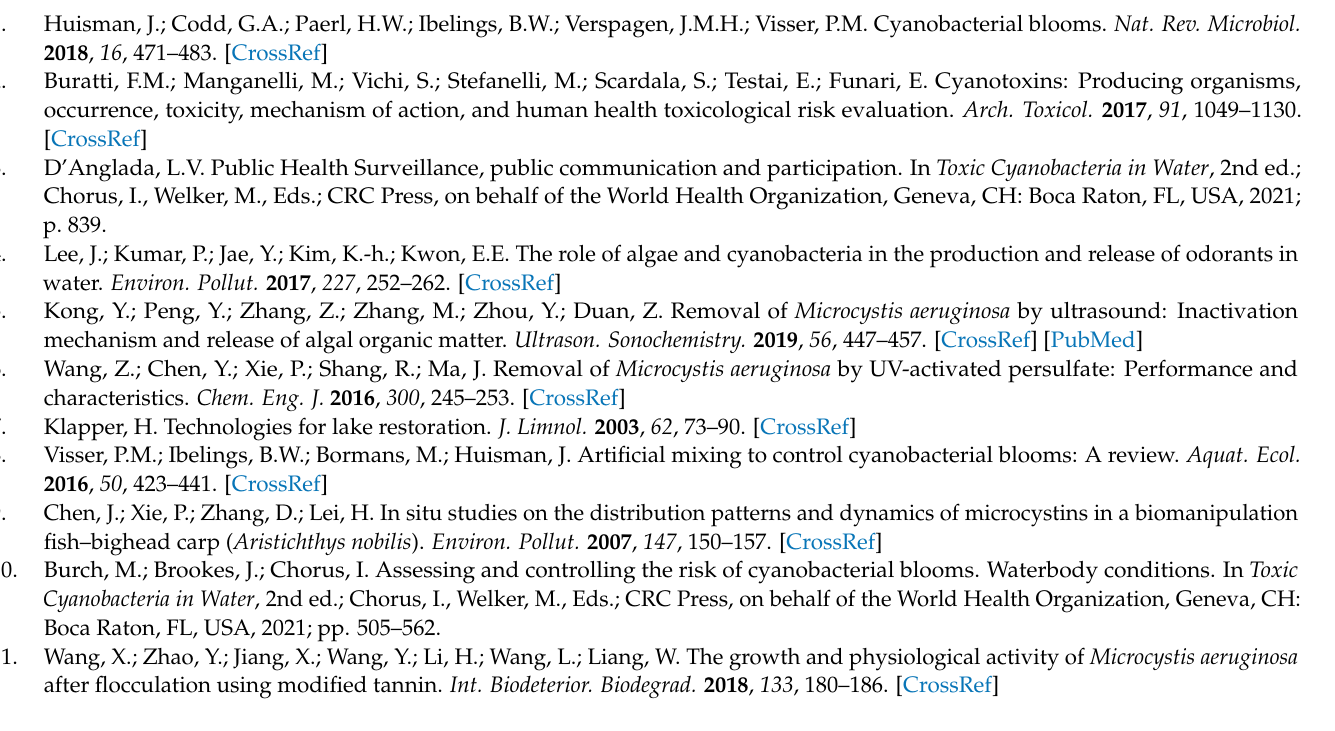
Table S2: Inhibition-zone diameters, minimal inhibitory concentrations (MIC) and minimal algicidal concentrations (MAC) of freshwater and marine macrophytes aqueous